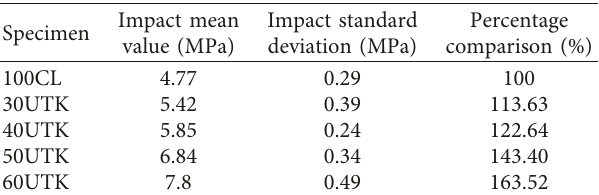
Figure 6: Impact resilience (kJ/m 2 ) vs. fiber content. Table 4: Detail values for impact